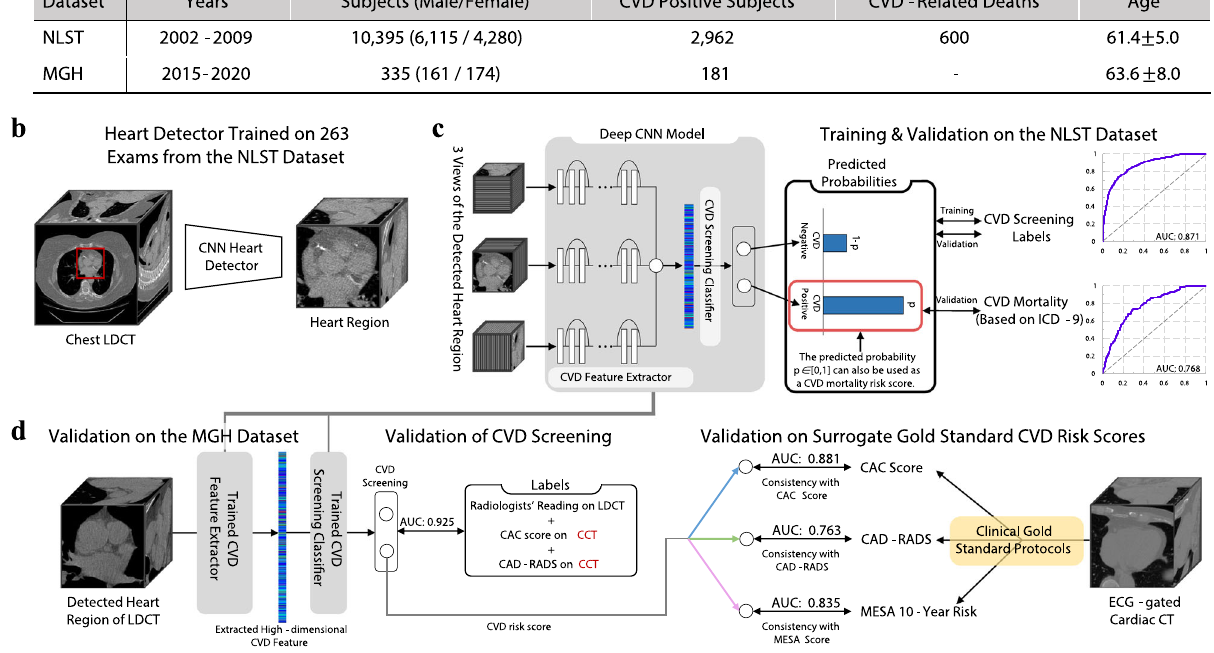
Fig. 1 Overview of the proposed deep learning work fl ow. a Public NLST and independent MGH datasets. The MGH dataset contains both LDCT and ECG- gated cardiac CT (CCT) images of 335 subjects. b To extract an image volume of the heart, a deep CNN heart detector was developed and trained. c A 3D CNN, Tri2D-Net, was designed for simultaneously screening CVD and predicting mortality risk. After training, the output probability of CVD positive also quanti fi es CVD mortality risk. d The proposed model was further validated on the MGH dataset.